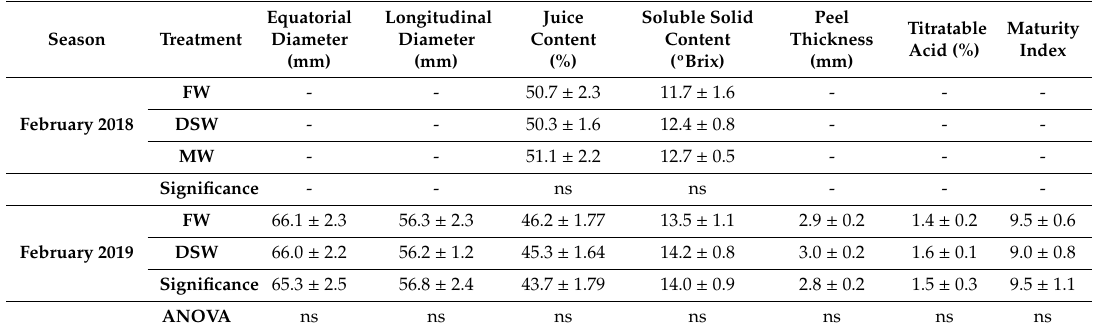
Table 4. Fruit quality parameters: equatorial and longitudinal diameters, juice and soluble solid content, peel thickness, titratable acidity, and maturity index for the two experimental seasons and for the three irrigation treatments (fresh water, FW; desalinated seawater, DSW; and mixed water, MW). ns means non-significant di ff erences between treatments according to Tukey’s HSD test (P ≤